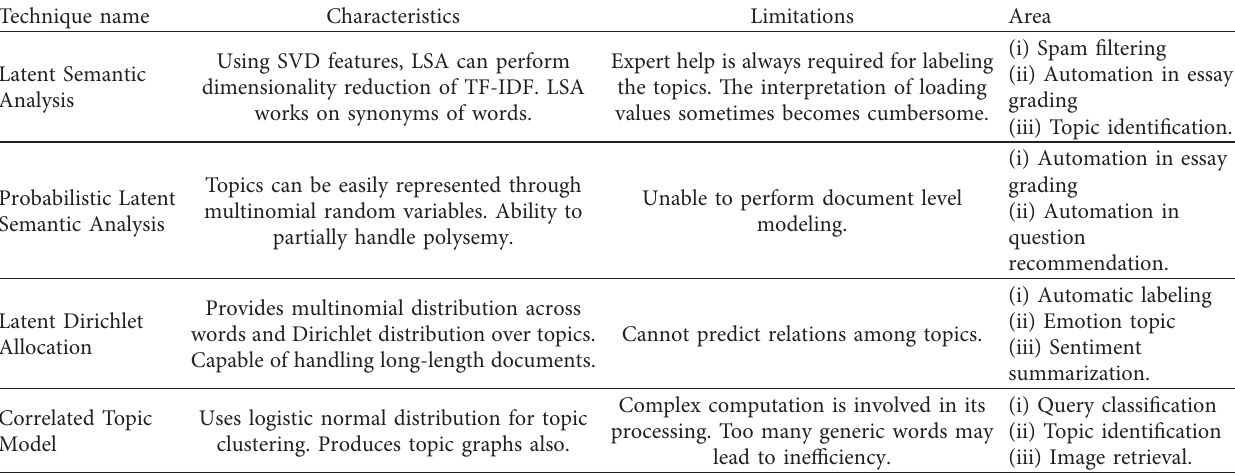
Table 1: Comparison of topic modeling